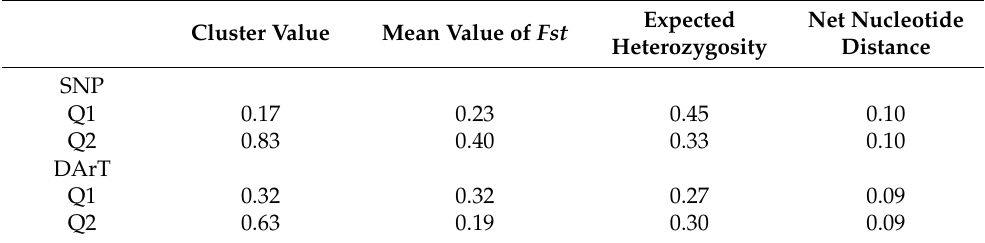
Table 2. Analysis of molecular variance (AMOVA) for 281 soybean germplasms based on SNP markers. Source MS Among Pops